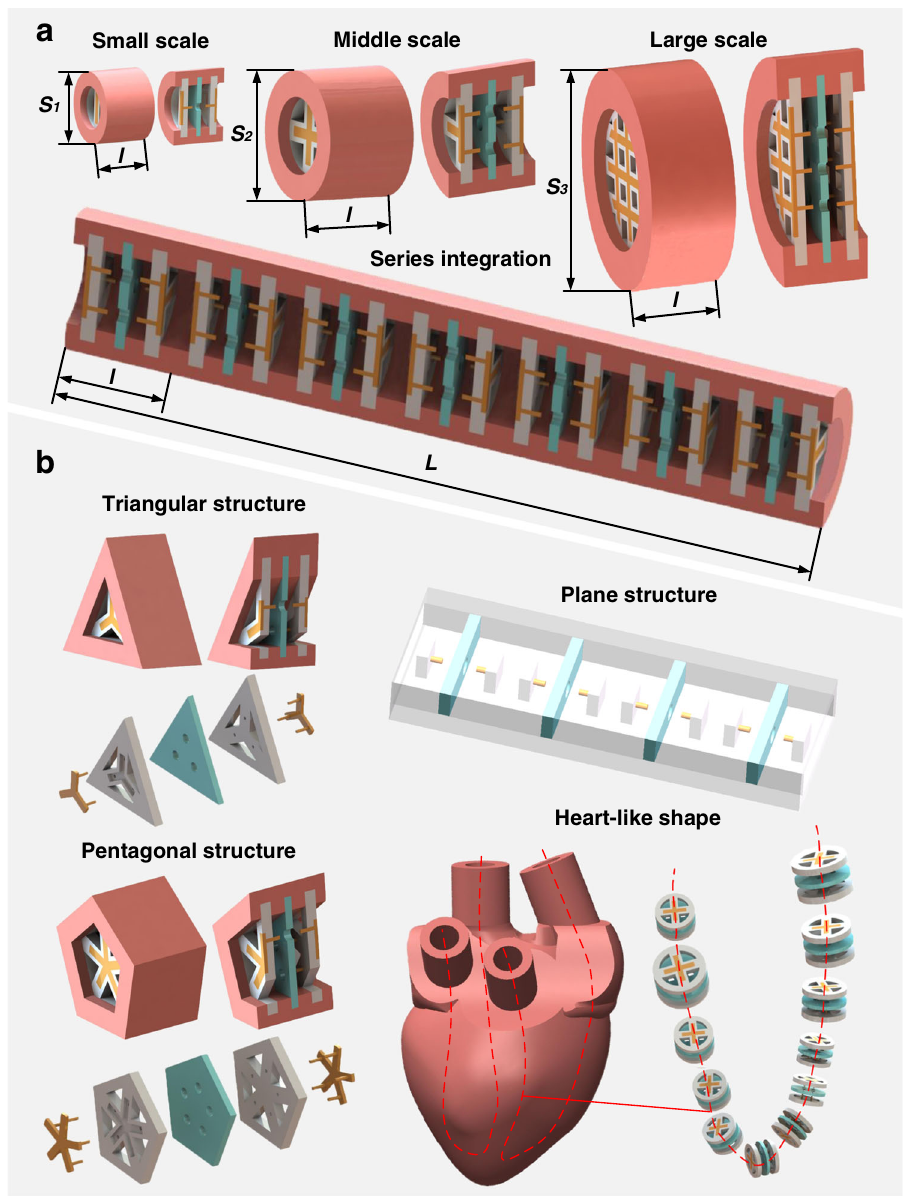
Fig. 2 Schematic illustration of customizable appearances of soft electronic pumps. a Various sizes of soft electronic pumps. The multiscale circumferential cross-sectional areas ( S 1 , S 2 , S 3 ) could be achieved by combining the different number of minimum electrode pair modular unit, while the multiscale axial length ( L ) can be achieved by integrating the different number of the pump. b Various shapes of soft electronic pumps. Different shapes, including triangular structure, pentagonal structure, plane structure, and complicated heart-like shape, could be achieved by changing electrode layout, support shape, and shell